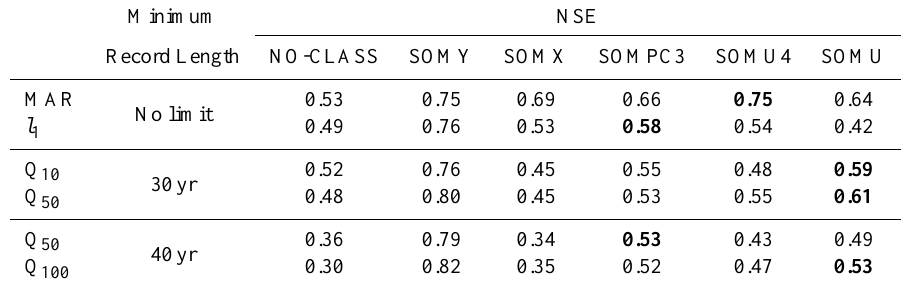
Table 5. Cross-validation of multiple regression models: NSE values for log-transformed streamflow indices ( Q T indicates the flood quantile with recurrence interval T , the highest NSE value among alternative classifications is highlighted in